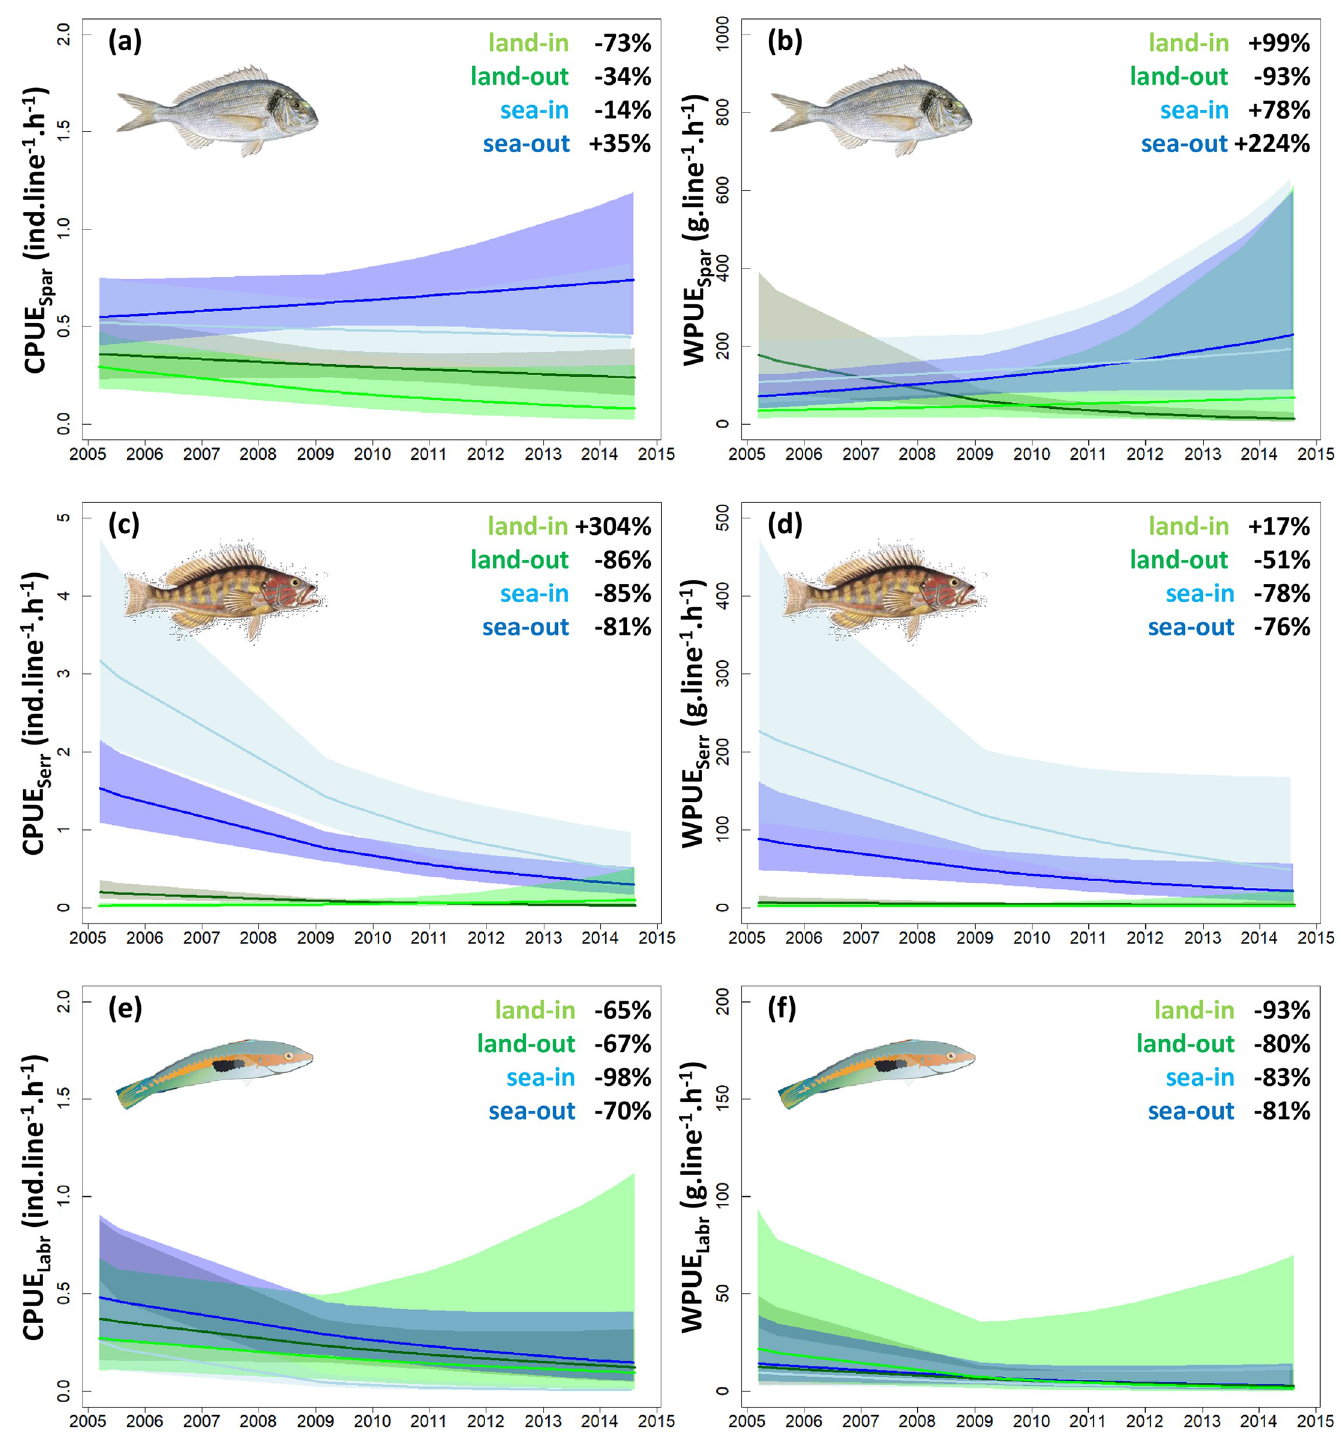
Fig 4. Trends in catch per unit effort (CPUE) and weight per unit effort (WPUE) of recreational fishermen fishing from land along the coastline (land) vs at sea from boats (sea), and inside (in) vs outside (out) the Cerb è re-Banyuls marine reserve for each of the 3 major fish families (Sparidae, Serranidae and Labridae). Note differences in scale in y-axes. Curves represent mean trajectories estimated by generalized linear models and shadings indicate 95% confidence intervals. The percent changes in mean CPUE and WPUE between the beginning and the end of the study period are provided as text on the plots. See S4 Table for mean and confidence interval values. Refer to S5 Table for parameter